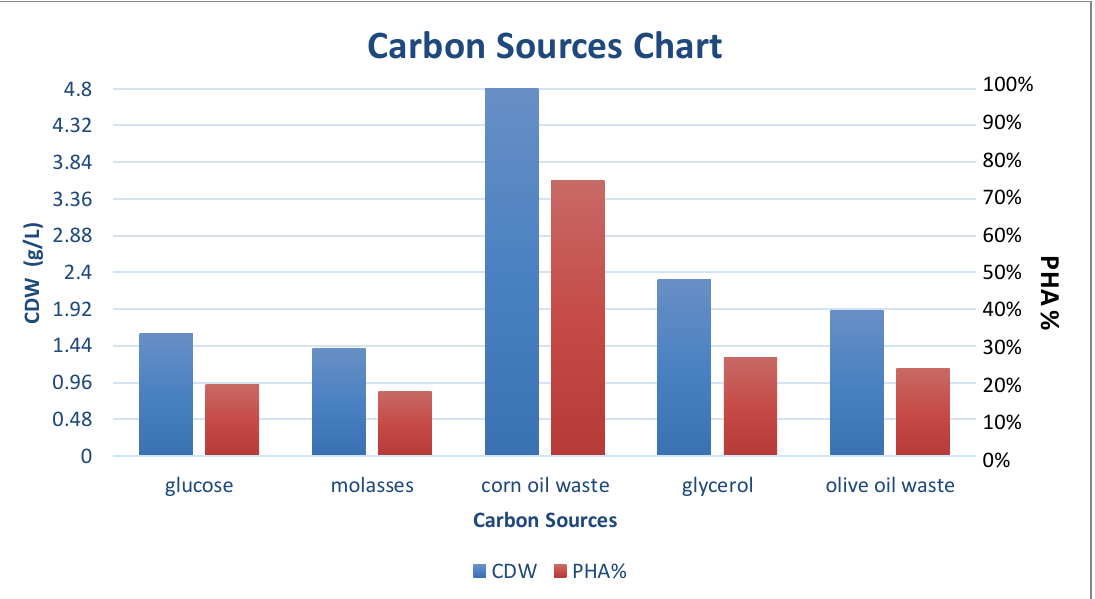
Figure 8 : Effect of various nitrogen sources on bacterial growth and PHA production.